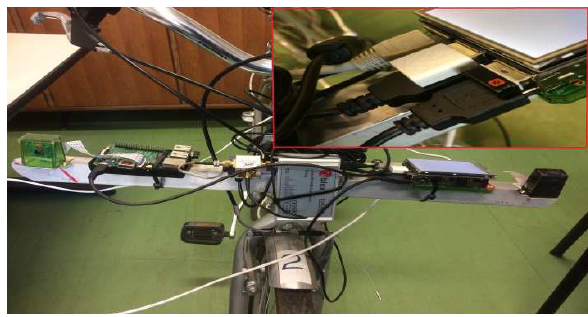
Figure 4. Bike mobile system with all sensors